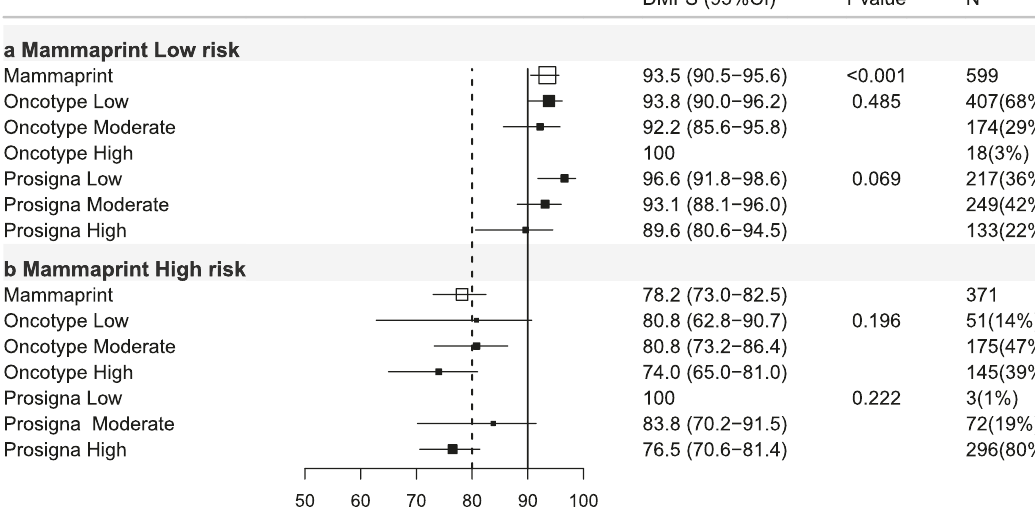
Fig. 7 Forest plot of Mammaprint-trained test results re-strati fi ed by other tests, Node-ve ER + ve/HER2 − ve cases treated without chemotherapy. DMFS10 = Distant metastasis free survival at 10 years post diagnosis. (95% CI) = 95% con fi dence interval, P = p value, N = number of cases in each subgroup, % = percentage of cases within each risk strata, X axis = percent distant metastasis free survival. Open boxes represent primary test DMFS10 by risk group. Solid boxes represent sub-strati fi cation by secondary tests with 95% con fi dence intervals (bars). Top panel ( a ) Mammaprint-trained low-risk cases strati fi ed by Oncotype-trained and Prosigna-trained results. Bottom panel ( b ) Mammaprint-trained high-risk